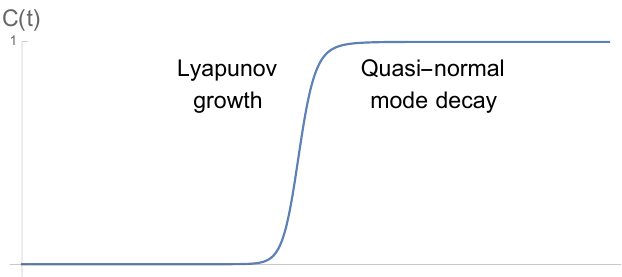
Figure 1. Schematic plot (based on [14]) of the expected behaviour of the normalized commutator squared C ( t ) over